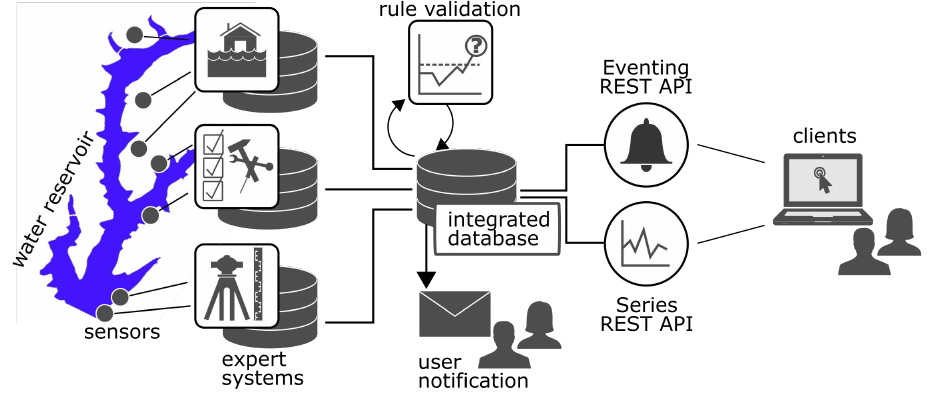
Figure 7. Architecture of the TaMIS